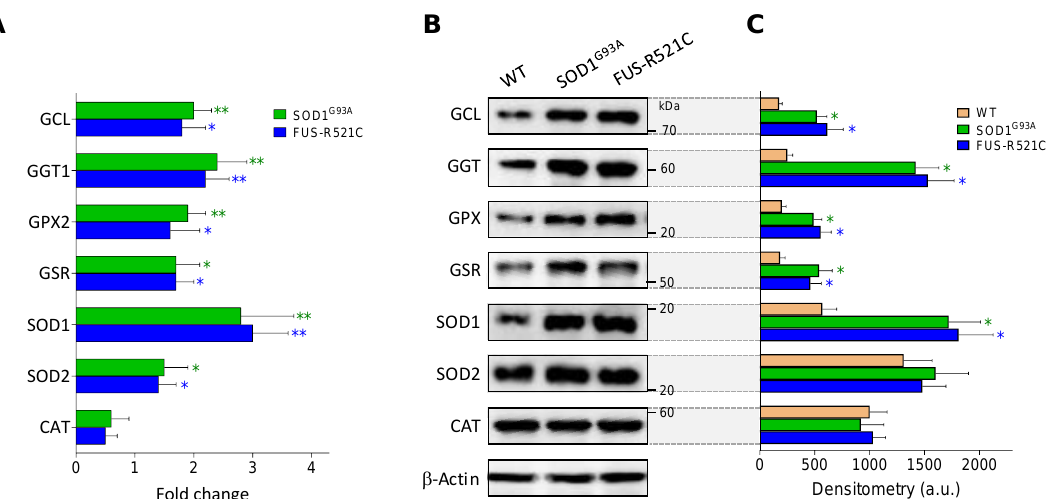
Figure 4. Expression and levels of GSH- and oxidative-stress-related enzymes in wild-type and ALS mice. ( A ) Data, expressed as fold change (quantitative RT-PCR; see Methods for calculations), show mean values ± SD for five different mice. ( B ) Western blots were performed in cell samples obtained from astrocytes isolated from wild-type mice and ALS mice at an advanced state of progression, thus facilitating correlations with the enzyme activities displayed in Tables 5, 6B and 8. ( C ) Densitometric analysis of the Western blots represents the mean values ± SD for five different mice per molecule. * p < 0.05, ** p < 0.01 comparing ALS mice versus wild-type controls.